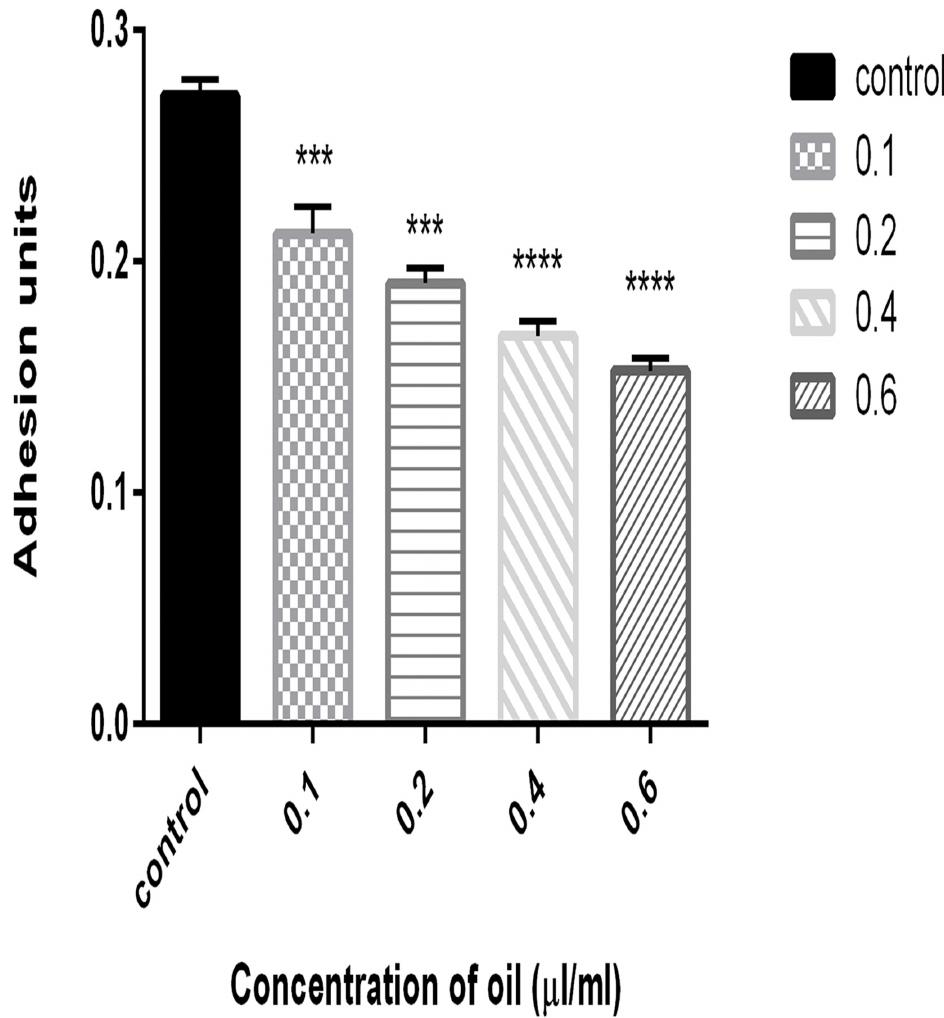
Fig 8. Quantification of PAO1 biofilms in the presence of various concentrations of cinnamon oil. The biofilms were quantified after 24 h of incubation and are represented as adhesion units (OD590/OD600). The error bars indicate the standard deviations of three measurements, and the data were normalized according to the OD 600 . *** , P < 0.0001 compared with the control. **** , P < 0.00001 compared with the